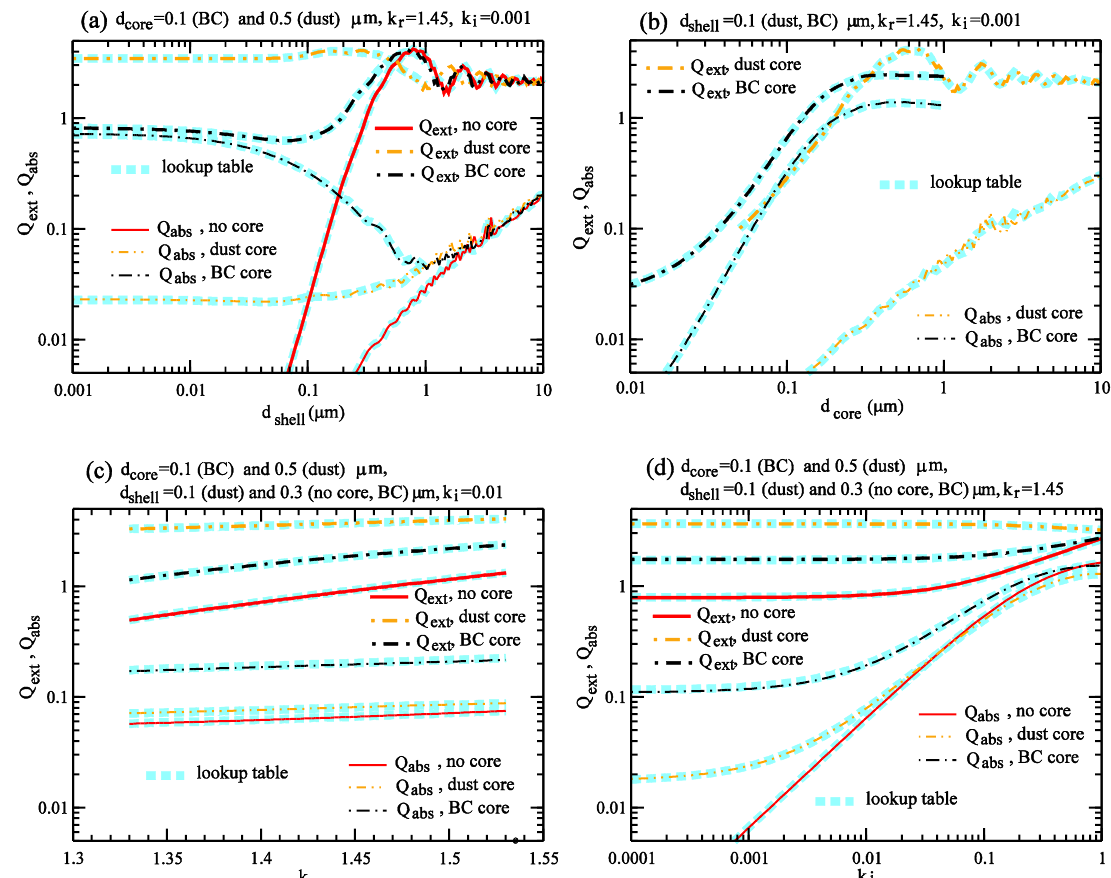
Fig. 2. Dependence of Q ext and Q abs on d core , d shell , k r and k i under selected conditions. The thick dashed cyan lines are values interpolated Figure 2 . from the look-up tables while all other lines are values calculated with the full Mie